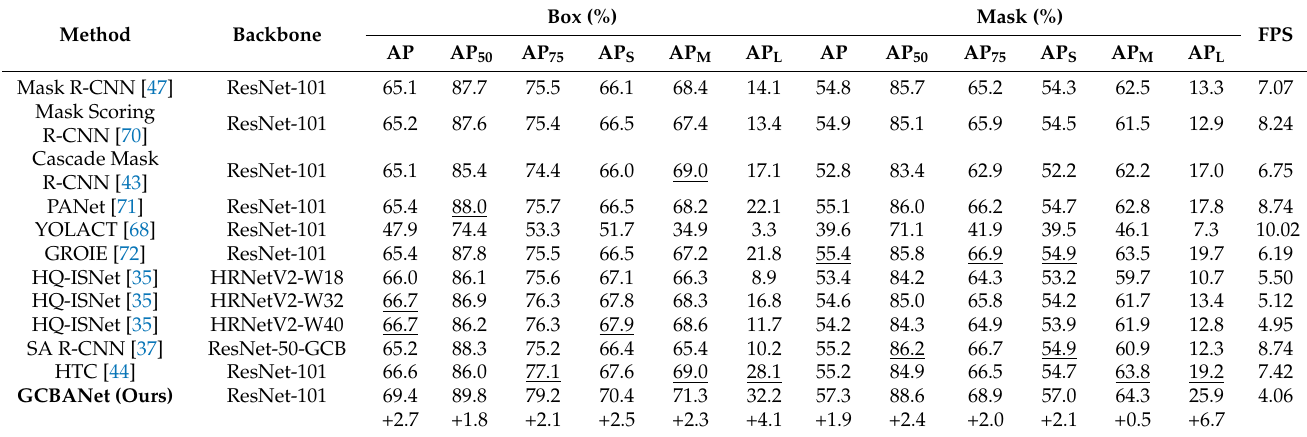
Table 3. Computational complexity calculations of different methods. Here, we adopt the floating point of operations (FLOPs) to measure calculations whose unit is the giga multiply add calculations Table 3. Quantitative results on HRSID. The suboptimal method is marked by Underline “—”. (GMACs) [69].